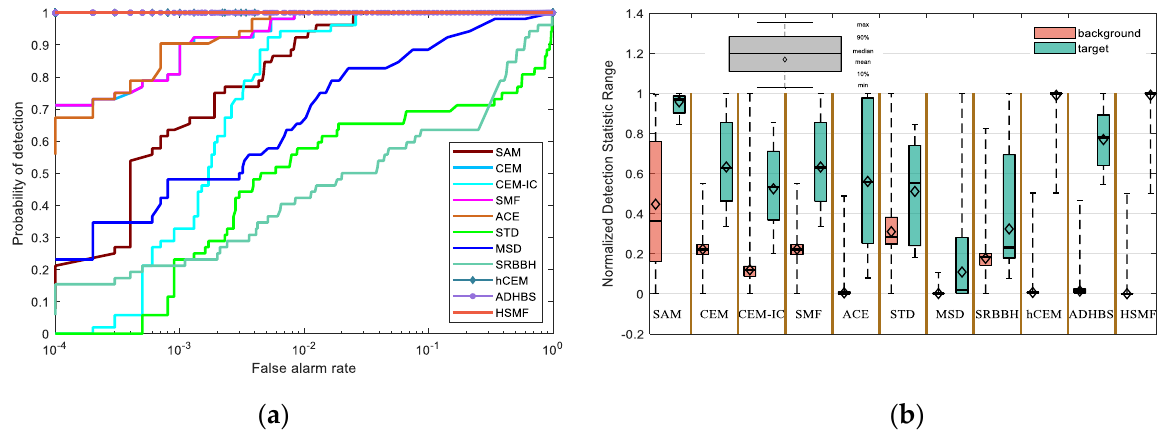
Figure 6. ( a ) ROC curves of different detectors on the Airport-Beach-Urban data. ( b ) The separability map of all detectors for the Airport-Beach-Urban data. Table 2. AUC values and AUC values at lower FAR of all detectors for the Airport-Beach-Urban data.